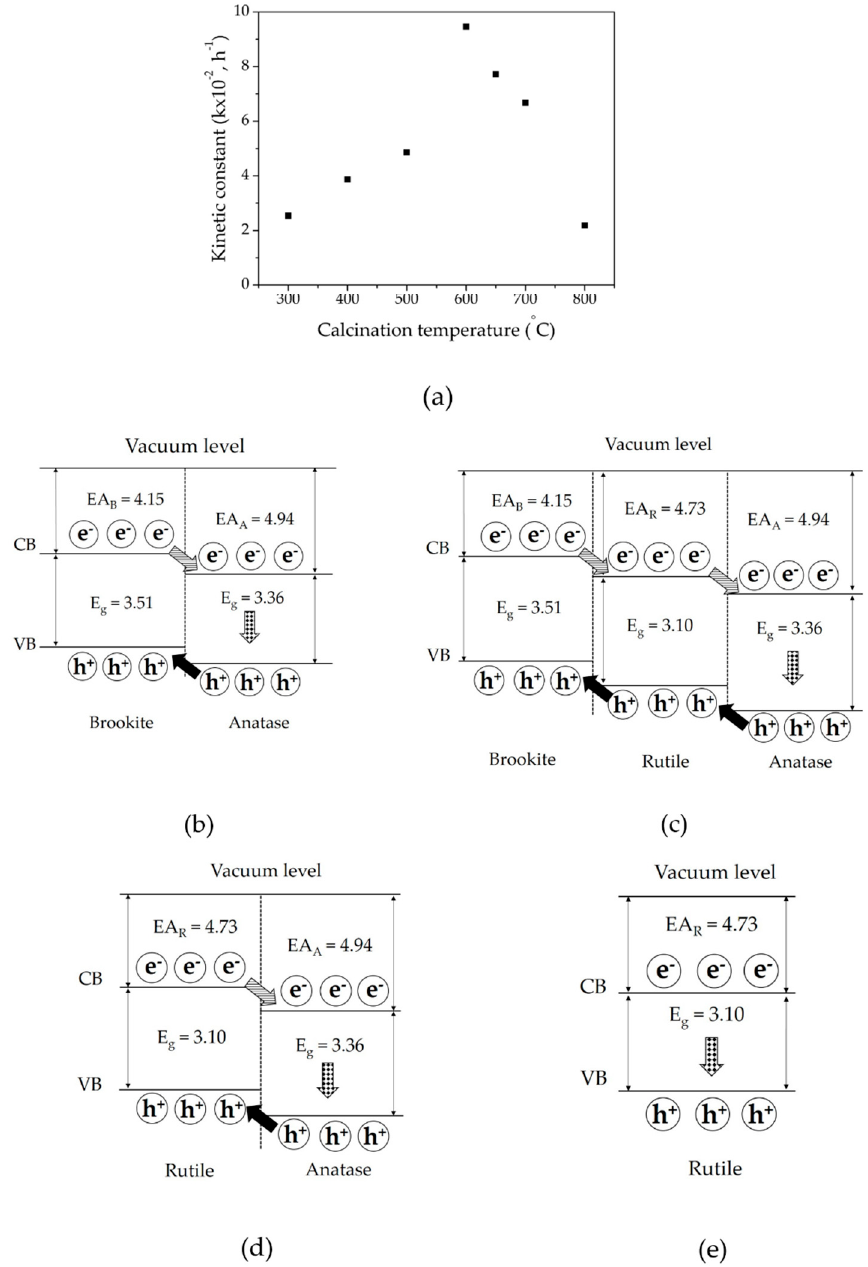
Figure 6. ( a ) Photocatalytic activity of TiO 2 presenting the kinetic constant at of TiO 2 as a function of calcination temperatures from 300 °C to 800 °C. Proposed mechanisms of different conduction and valence band alignments of ( b ) anatase–brookite, ( c ) anatase–rutile–brookite, ( d ) anatase–rutile, and ( e ) rutile phase. Striped and black arrows show electron transfer in conduction band and hole transfer in valence band, respectively. Checkerboard arrow represents a recombination of electrons and holes.